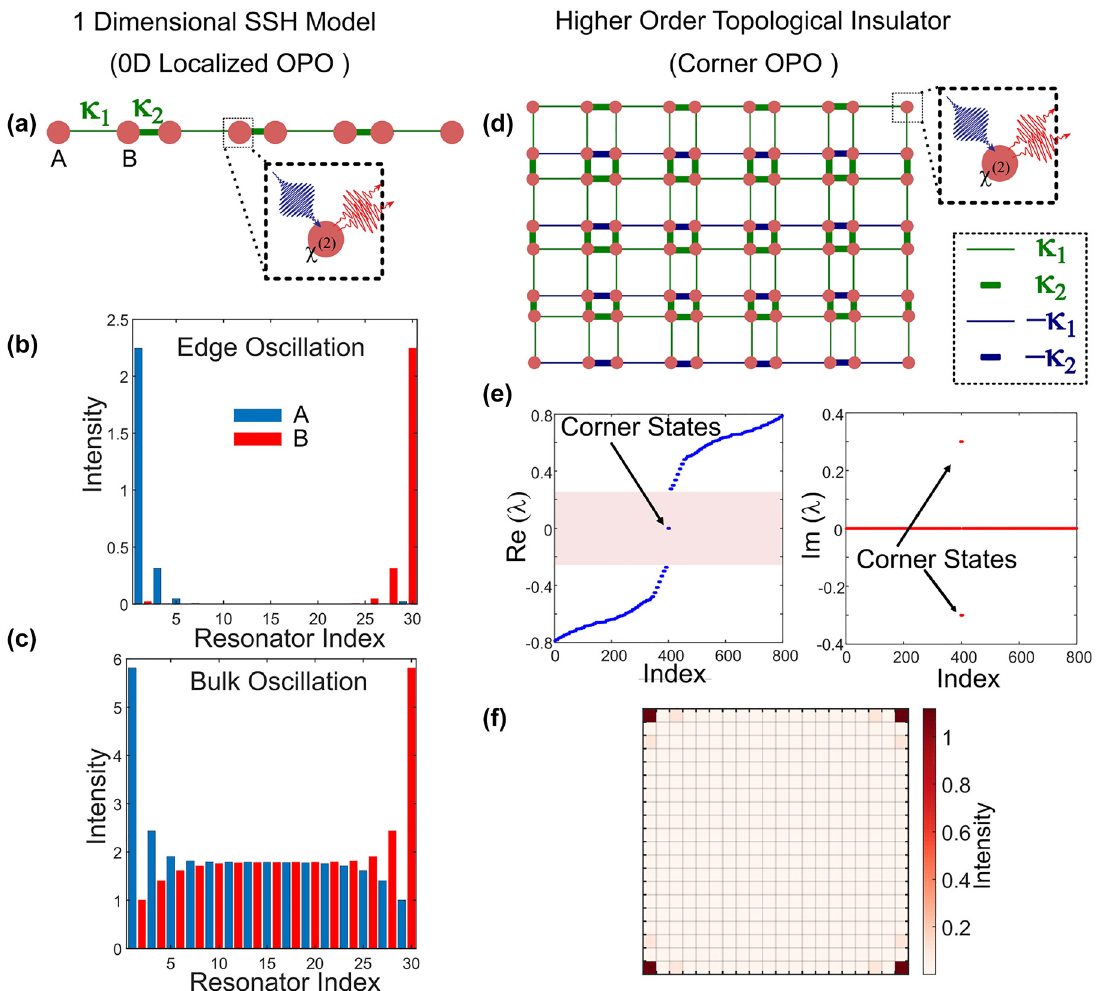
Figure 2: Nonpropagating topological parametric oscillation. (a) Schematic of 1D SSH model of quadratic nonlinear resonators hosting 0D localized edge modes, where the intra-cell coupling ( 𝜅 , thick lines). (b) Parametric oscillation when only the edge modes experience instability, lines) is weaker than the inter-cell coupling ( 𝜅 2 while the bulk modes are stable. (c) Oscillation when the parametric gain also induces instability in the bulk modes. (d) Schematic of 2D lattice of quadratic nonlinear resonators hosting corner modes. Thick and thin lines indicate strong and weak coupling, respectively, while green and blue color represents positive and negative couplings. (e) Eigenvalue diagram (the real part (left) and the imaginary part (right)) showing the corner states lying within the bandgap with nonzero imaginary part while the bulk modes are stable. (f) Parametric oscillation in the corner modes of the 2D